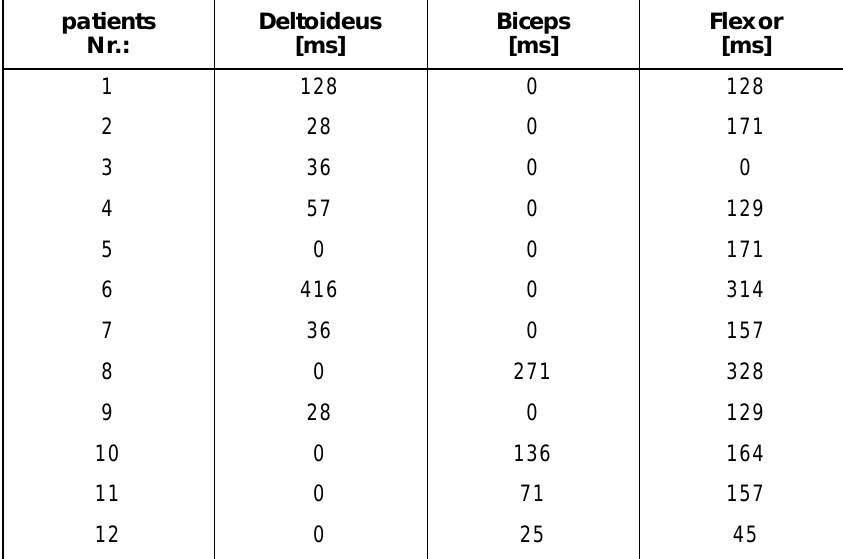
Table 6: Innervation sequences in anteversion of hemiparetic patients.